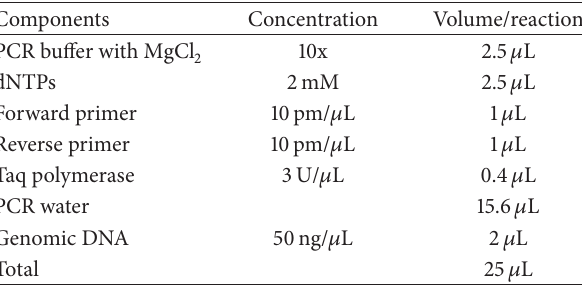
Table 3: Optimized component concentrations for PCR.